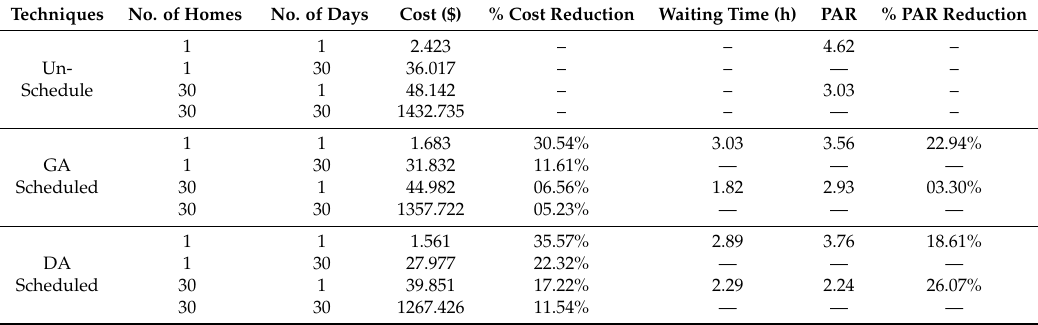
Table 2. Results summary of Un-Scheduled, Genetic algorithm (GA), and Dragonfly algorithm (DA) based scheduled load.